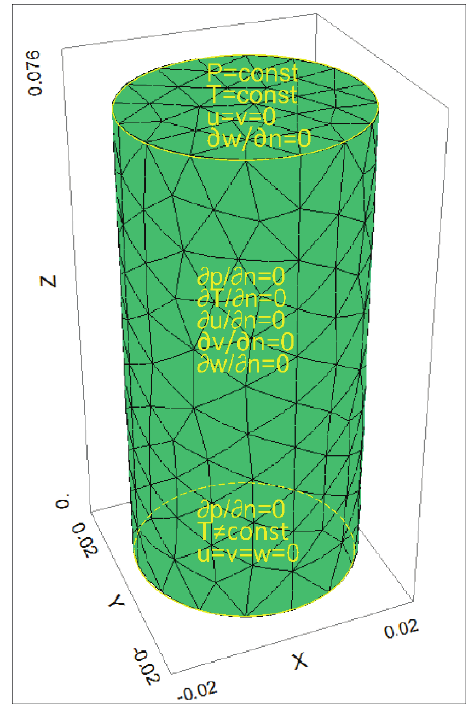
Fig. 1. Model geometry and boundary